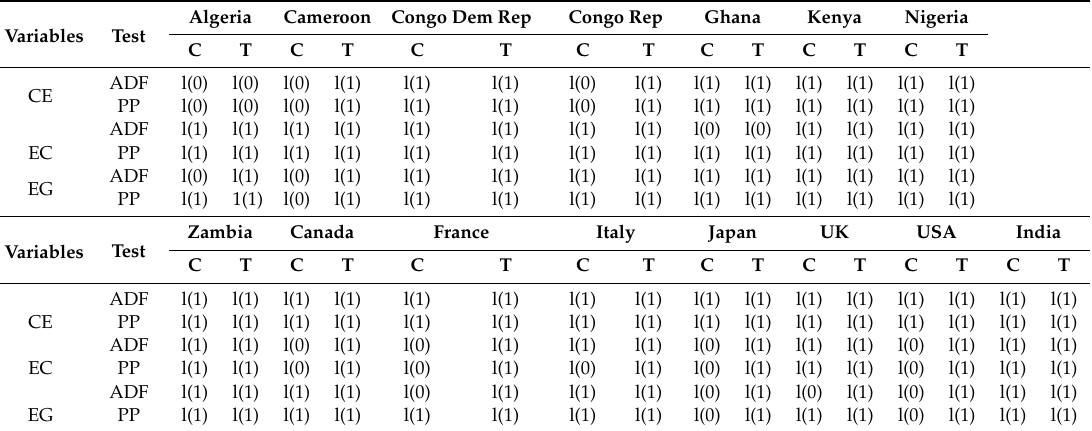
Table 3. Stationarity test